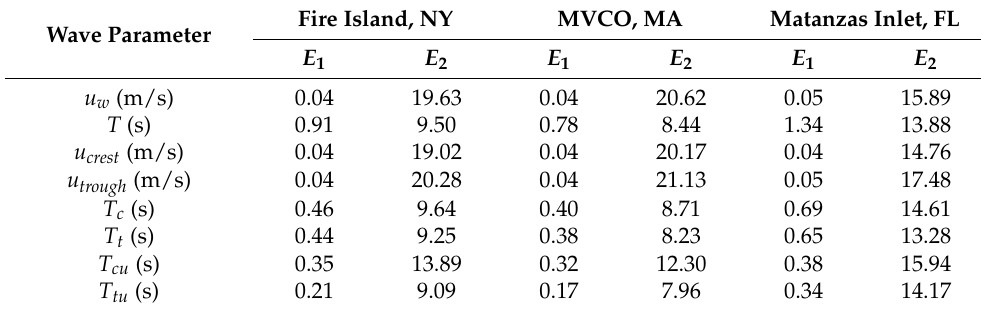
Table 4. Errors between direct and parameterized waveform characteristics at all three sites where E 1 = RMSE i and E 2 = 100 ( RMSE i ) / RMS id where subscript “ i ” is for an individual waveform characteristic and subscript “ d ” refers to the direct method.